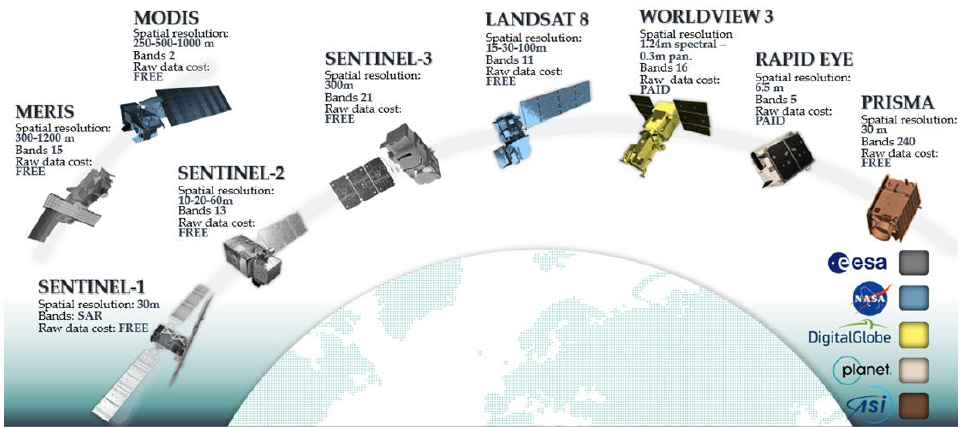
Figure 11. The proposed and most compatible satellite sensors based on the findings of this review for the support of the